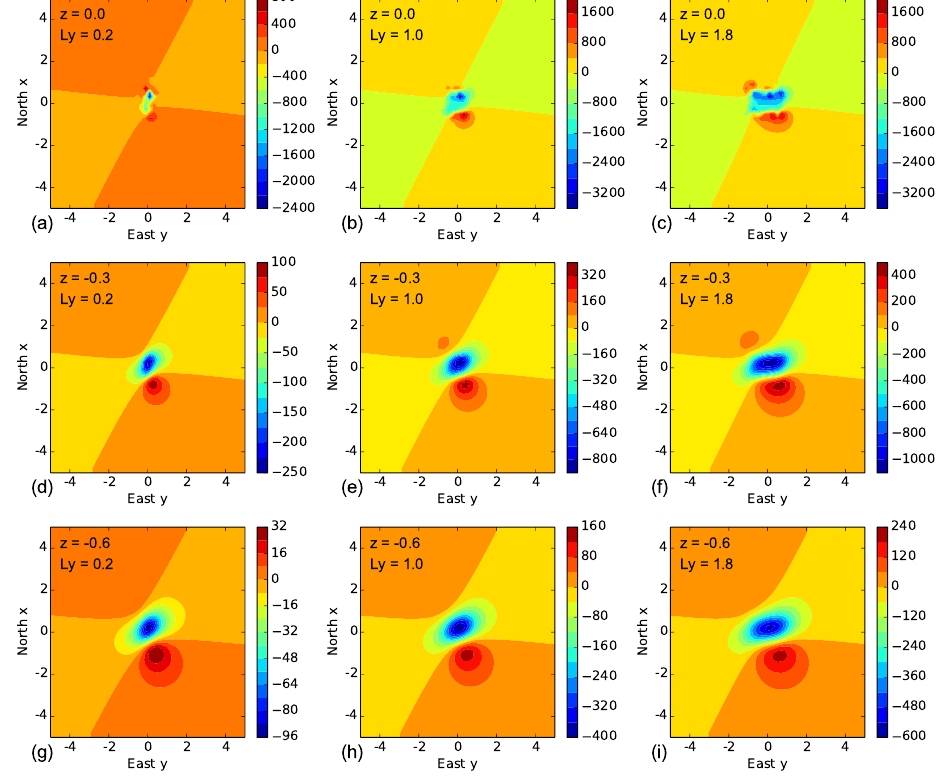
Figure 5. Robustness against non-spherical sources. Noise-corrupted total-field anomaly produced by each one of the three rectangular prisms shown in Fig. 4b on three horizontal planes with different constant vertical coordinates z (dashed lines in Fig. 4b). We consider that the centres of all prisms are located at xc = 0 . 00, yc = 0 . 00 and zc = 0 . 51. The intensity, declination and inclination of the magnetization vectors of all prisms are equal to 6Am − 1 , and − 40 and 30 ◦ , respectively. The simulated geomagnetic field is constant, with declination − 15 ◦ and inclination − 10 ◦ . The data are in nT and all coordinates and lengths are dimensionless (see Fig. 4).